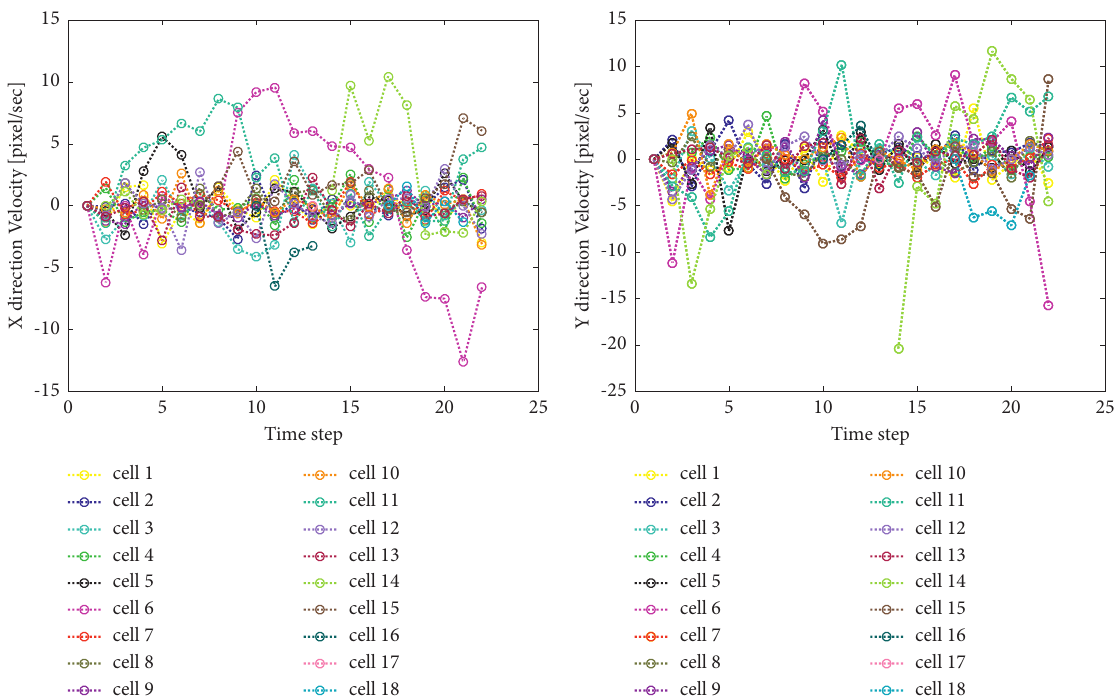
Figure 7: Instant velocity estimation of each cell in x and y coordinates.